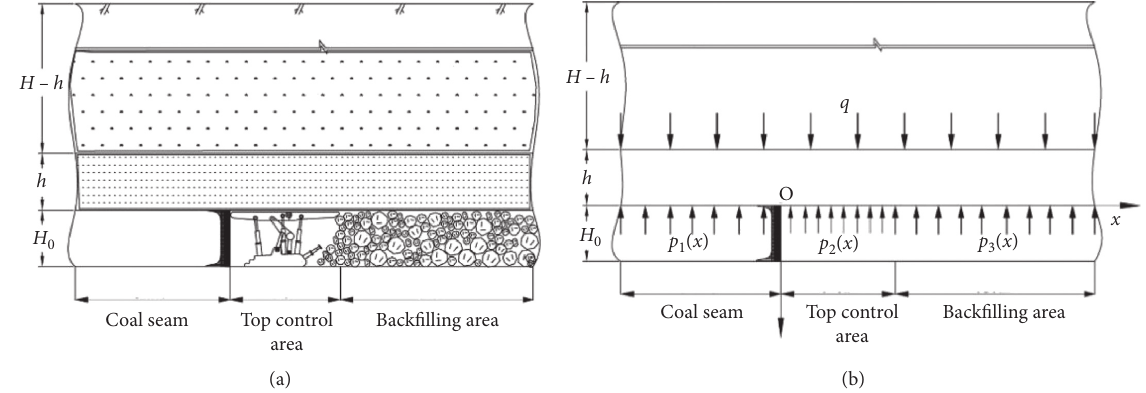
Figure 1: Mechanical model of backfilling mining support-roof rock beam-filling